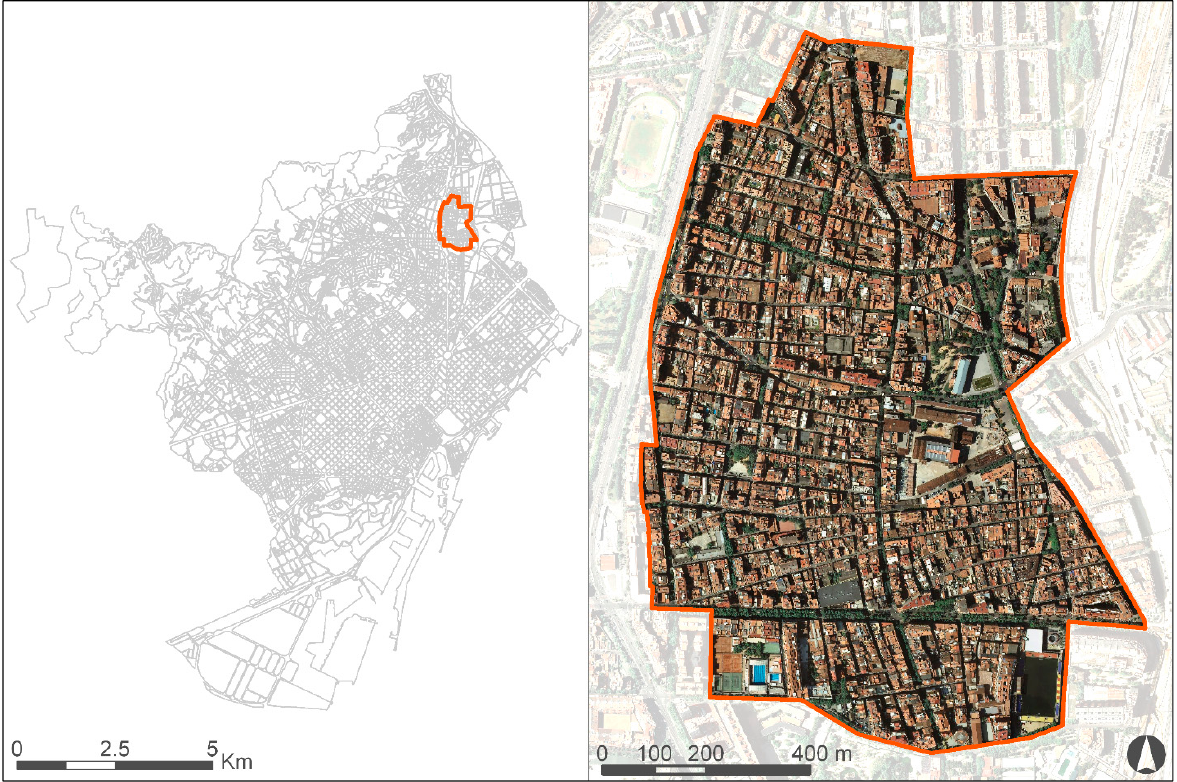
Figure 1. Area of study in the Sant Andreu District of